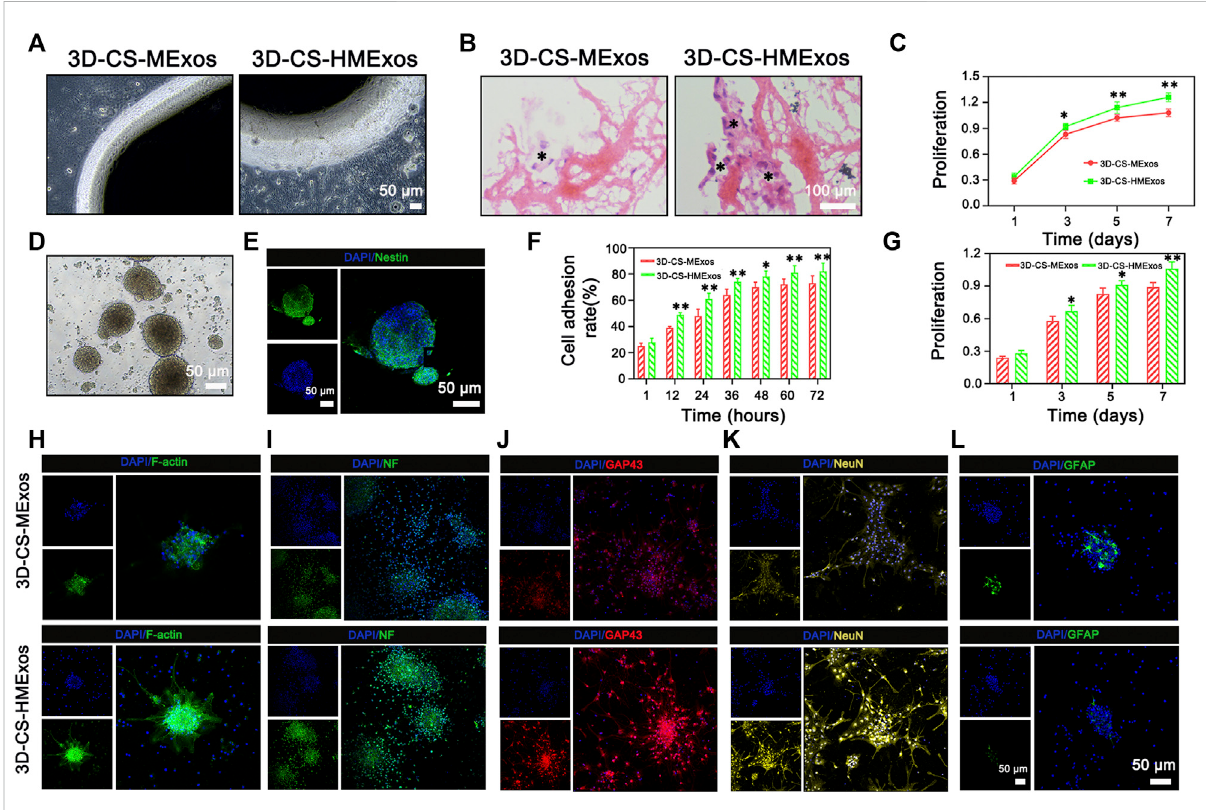
FIGURE 3 In vitro biological response of NSCs and HUCMSCs to 3D-CS-MExos or 3D-CS-HMExos. (A) Representative images of HUCMSCs coincubated with 3D-CS loaded with MExos or HMExos under a phase contrast microscope. (B) The morphology of 3D-CS-MExos and 3D-CS-HMExos after 7 days of coincubation with HUCMSCs assessed by HE staining. (C) Cell proliferation evaluated by CCK-8 assay after 1, 3, 5, and 7 days of culture in the scaffolds. (D) Representative images of NSCs under a phase contrast microscope after culture for 7 days. (E) Immuno fl uorescence staining identi fi cation veri fi es NSCs. Green and blue represent Nestin and DAPI, respectively. (F) Quanti fi cation analysis of the NSC adhesion rate of the 3D- CS-MExos/HMExos scaffold. (H) Cell adhesion analysis of NSCs was evaluated by cytoskeleton staining. Green: F-actin; blue: DAPI. (G) CCK-8 analysis of NSCs was also used to evaluate the biocompatibility of scaffolds in vitro . The proliferation rate of NSCs on the 3D-CS-HMExos scaffold wassigni fi cantlyhigherthanthatonthe3D-CS-MExosscaffold. (I – L) Immuno fl uorescencestaininganalysistoverifythedifferentiationofNSCsafter 7 days of incubation in scaffolds with NF, GAP43, NeuN, and GFAP antibodies. * p < 0.05, ** p < 0.01 vs.